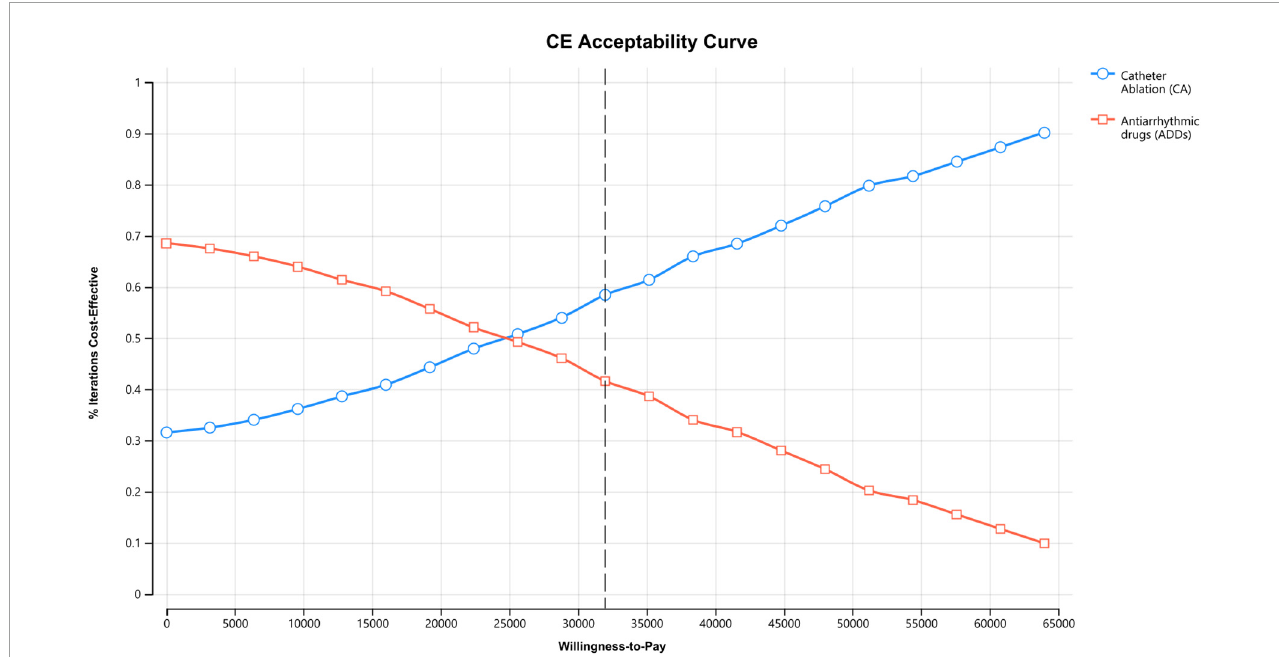
FIGURE4 Cost-effectiveness acceptability curve of ablation vs. antiarrhythmic drugs for treating atrial fibrillation (AF).